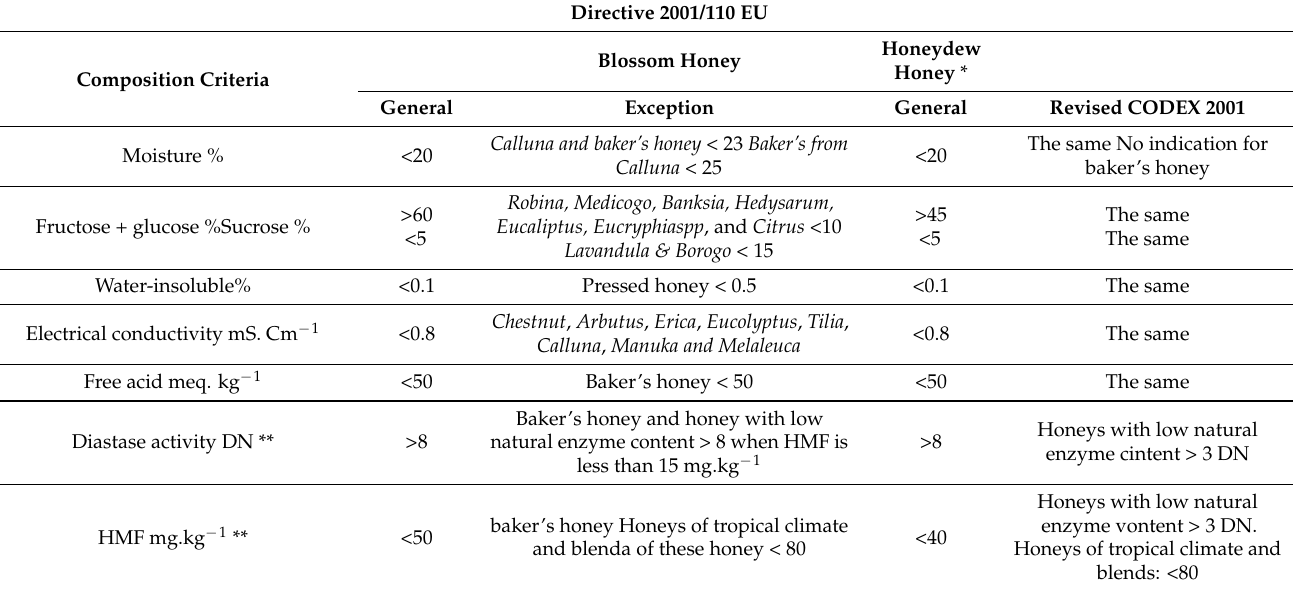
Table 1. Compositional criteria of